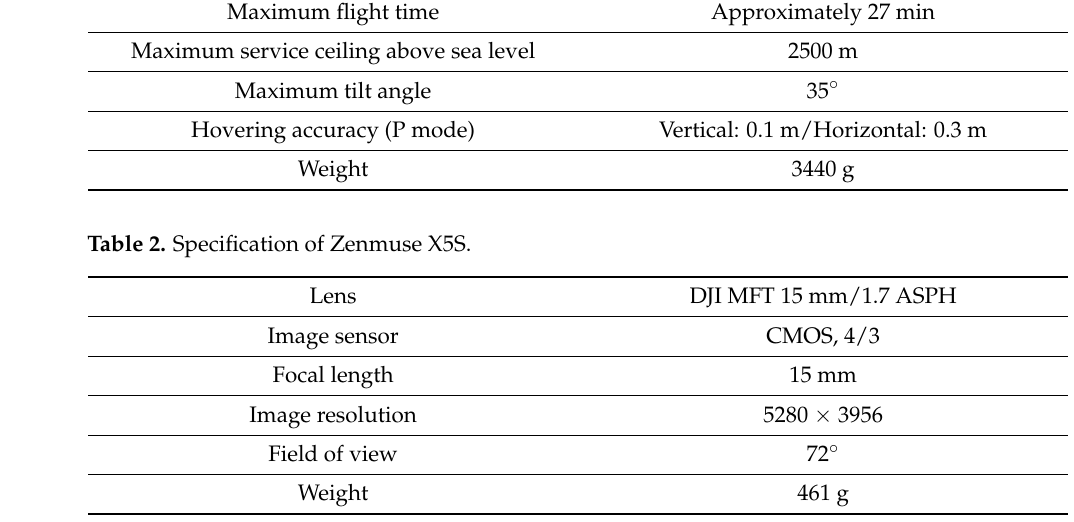
Table 1. Specification of Inspire 2. Figure 6. Unmanned aerial photography equipment. ( a ) DJI Inspire 2; ( b ) Zenmuse X5S.